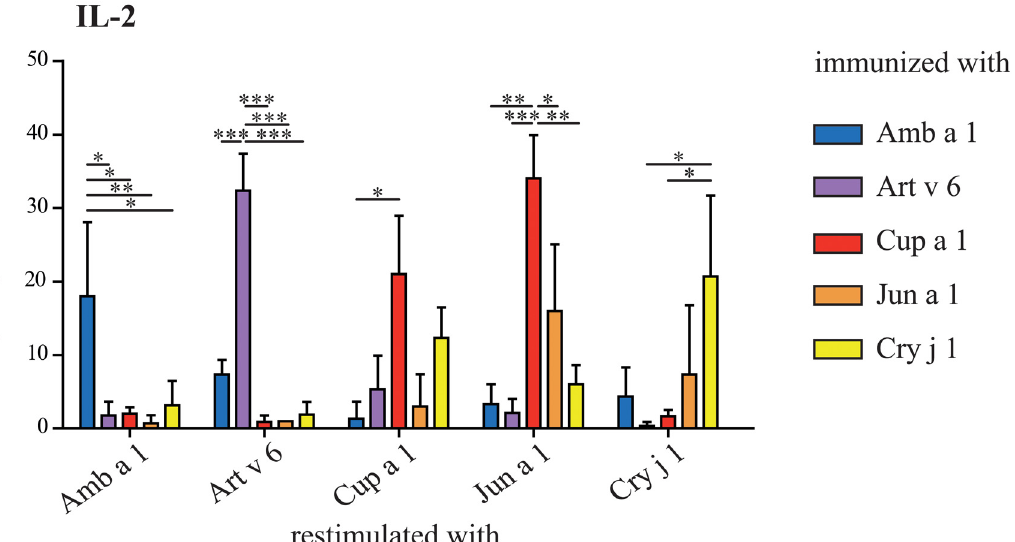
Fig 8. Proliferation of re-stimulated splenocytes. Activation of T cells was observed by the induction of IL-2 secreting cells. Therefore, splenocytes of immunized animals (n = 5 animals/ group) were re-stimulation with each of the five pectate lyase allergens. IL-2 secreting cells were detected by ELISpot. Results are presented as mean ± SD. Statistical analysis was performed with One-way ANOVA and Tukey´s Multiple Comparison Test ( * P < .05, ** P < .01, *** P <